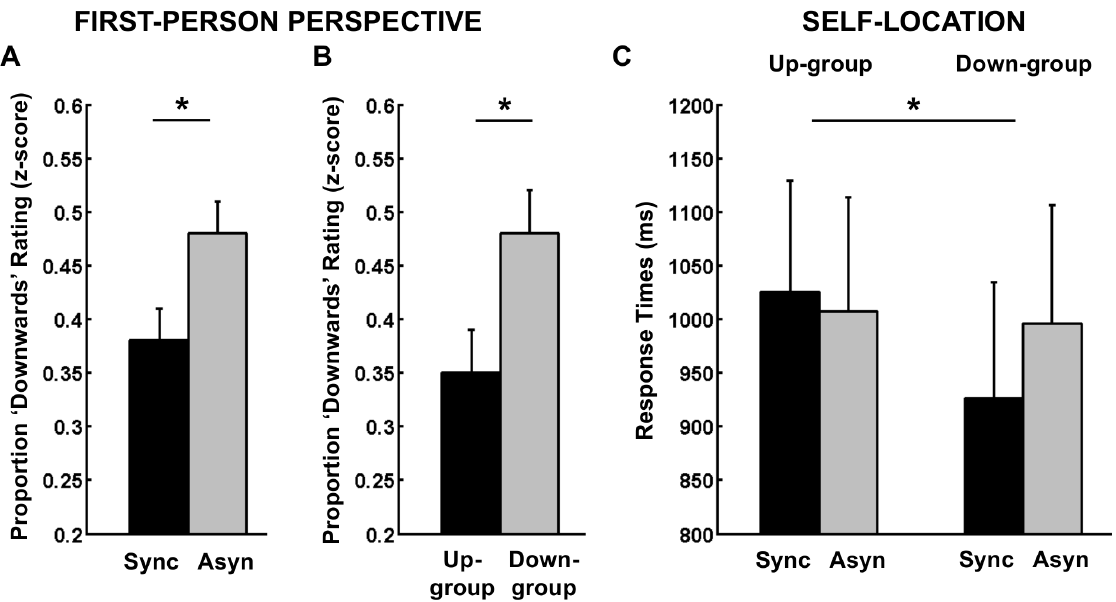
Figure 3. Results of Experiment 2. Frequency of ‘‘downwards’’ ratings for the experienced direction of the first-person perspective showing the main effect of Stroking (A) and Group (B). (C) Self-location results showing average response times in the Mental Ball Dropping task. Error bars indicate standard error of the mean.